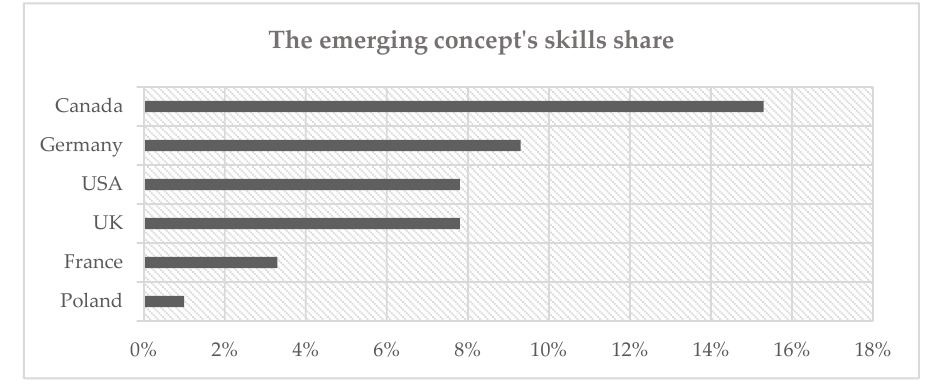
Figure 9. The amount of demand on studied concept skills for energy executives by country.